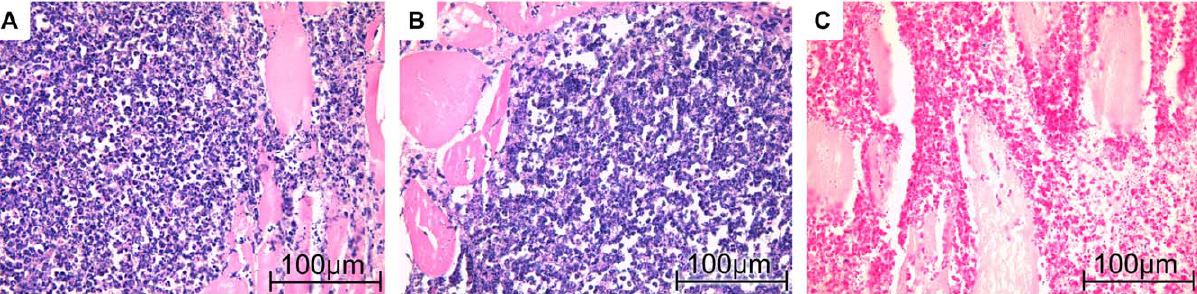
Figure 6. Histological appearance of acute soft-tissue infection. A, C) Mice received CLIO at day 2 post infection and were imaged 24 h after administration. The muscle was recovered immediately after imaging. B) Mice received PFC at day 2 post infection. Images were recorded 24 h after administration. The muscle was recovered immediately after imaging. A) HE-staining shows that infiltrate in CLIO group mice consists mainly of granulocytes. C) Iron-specific staining demonstrates iron deposits in granulocytes and macrophages (iron appears blue). B) HE-staining of PFC group mouse reveals strong immune cell infiltrate mainly consisting of granulocytes.